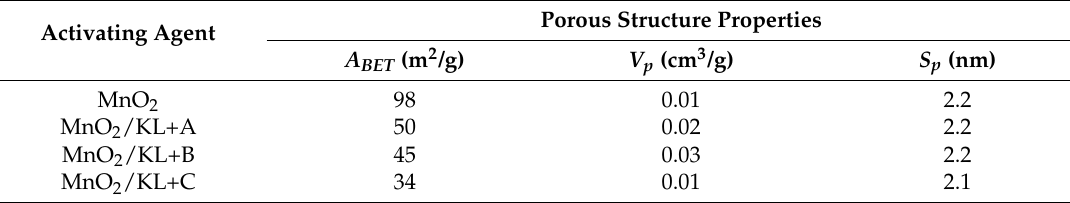
Table 5. Parameters of porous structure of manganese oxide and MnO 2 /lignin hybrid materials based on biopolymer activated in selected ionic liquids.